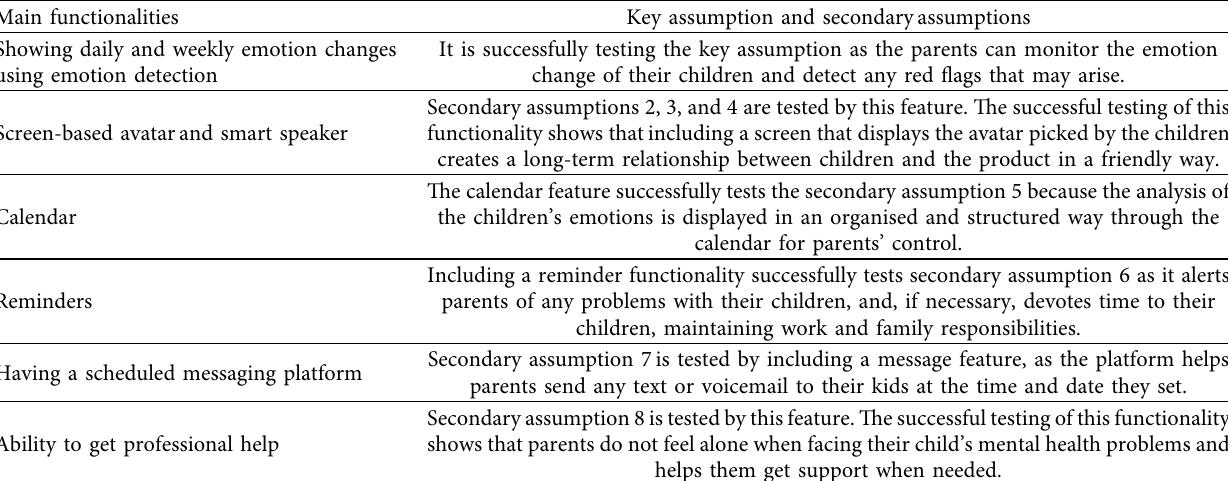
Table 1: Visualization of the design solutions related to the assumptions made. Key assumption and secondary assumptions